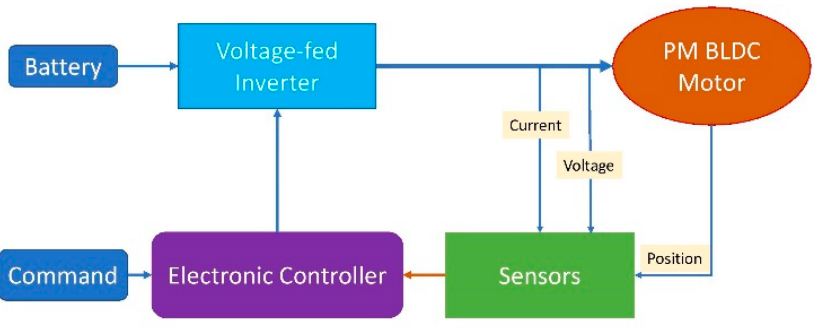
Figure 8. Basic set up of PMBLDC motor system.